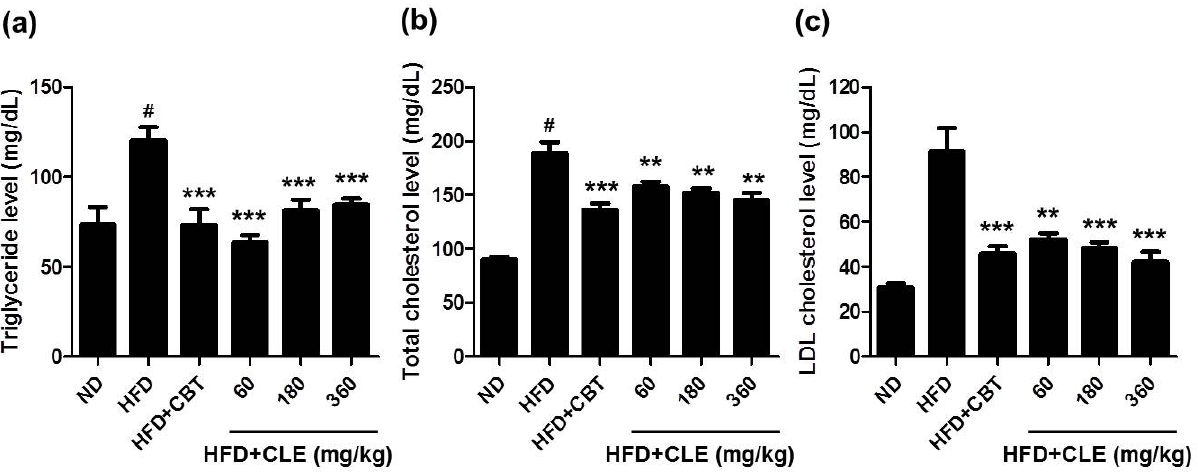
Figure 4. Effect of CLE on serum cholesterol levels of mice fed a HFD. ( a ) Serum triglyceride. ( b ) Serum total cholesterol. ( c ) Serum LDL cholesterol. The serum biochemical parameters were assessed in mice fed a ND, a HFD, a HFD with reductil (2 mg/kg), and a HFD with CLE (60, 180 and 360 mg/kg). Values are the mean ± SEM ( n = 10), # p < 0.05 vs. ND-fed mice, ** p < 0.01, *** p < 0.001 vs. HFD-fed mice.